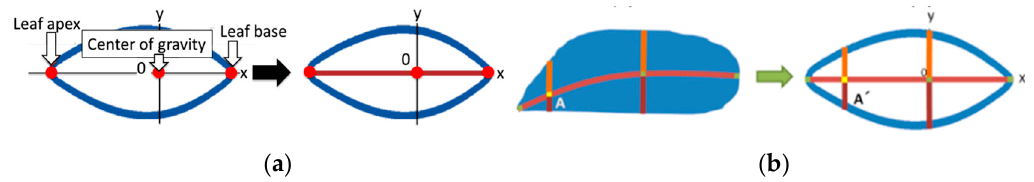
Figure 17. Mapping of the leaf to the template: ( a ) Sample of the mapping; ( b ) apply this mapping method to real leaf.